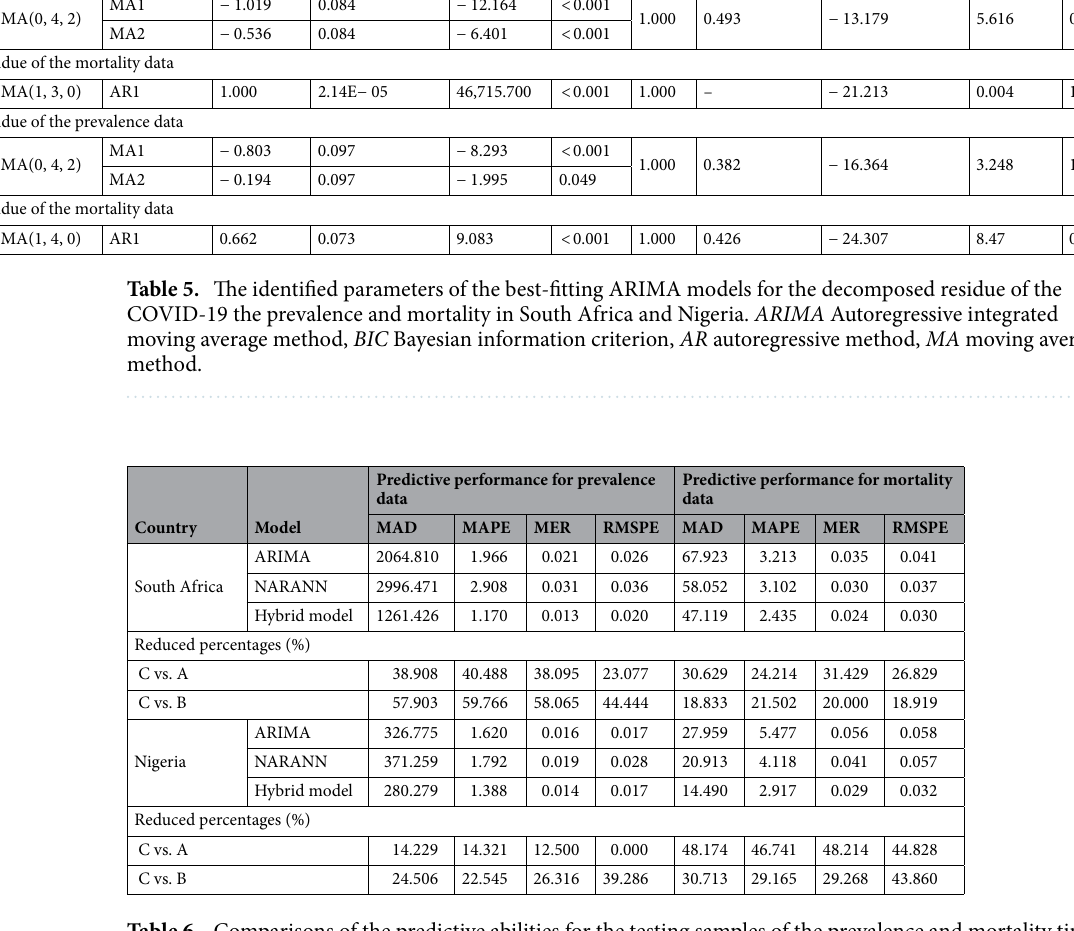
Table 6. Comparisons of the predictive abilities for the testing samples of the prevalence and mortality time series of COVID-19 among these three selected models in South Africa and Nigeria. ARIMA Autoregressive percentage error, A refers to the ARIMA model, B refers to the NARANN model, C refers to the EEMD- ARIMA-NARANN hybrid